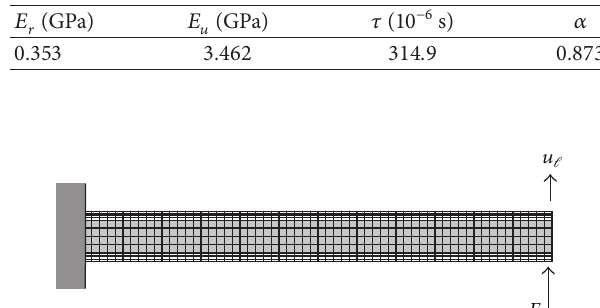
Table 1: Parameters of the fractional derivative model.